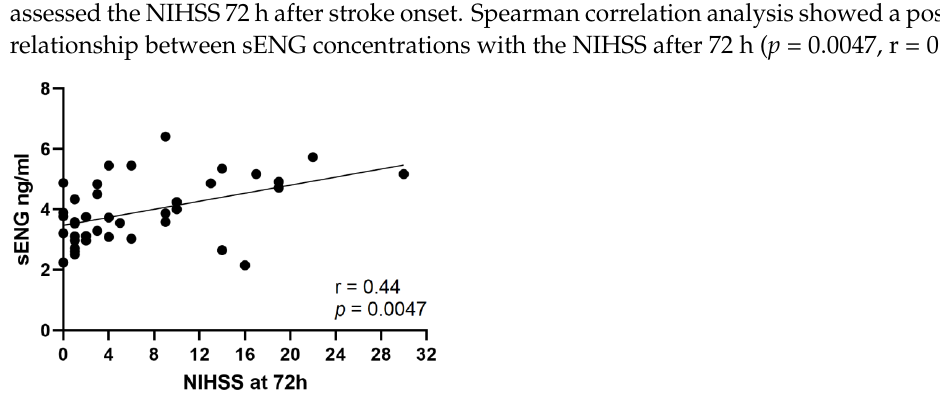
Figure 2. Positive correlation of sENG concentrations with the NIHSS 72 h after stroke onset in patients with partial or complete (corresponding to TICI 2C or TICI 3) recanalization. Spearman correlation coefficient ( n = 39, r = 0.44, p = 0.0047).